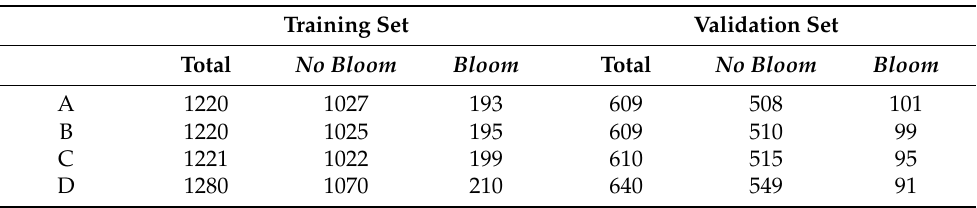
Table 3. Number of records available for de training and validation of the models for each combina- tion of features (A, B, C or D, see Table